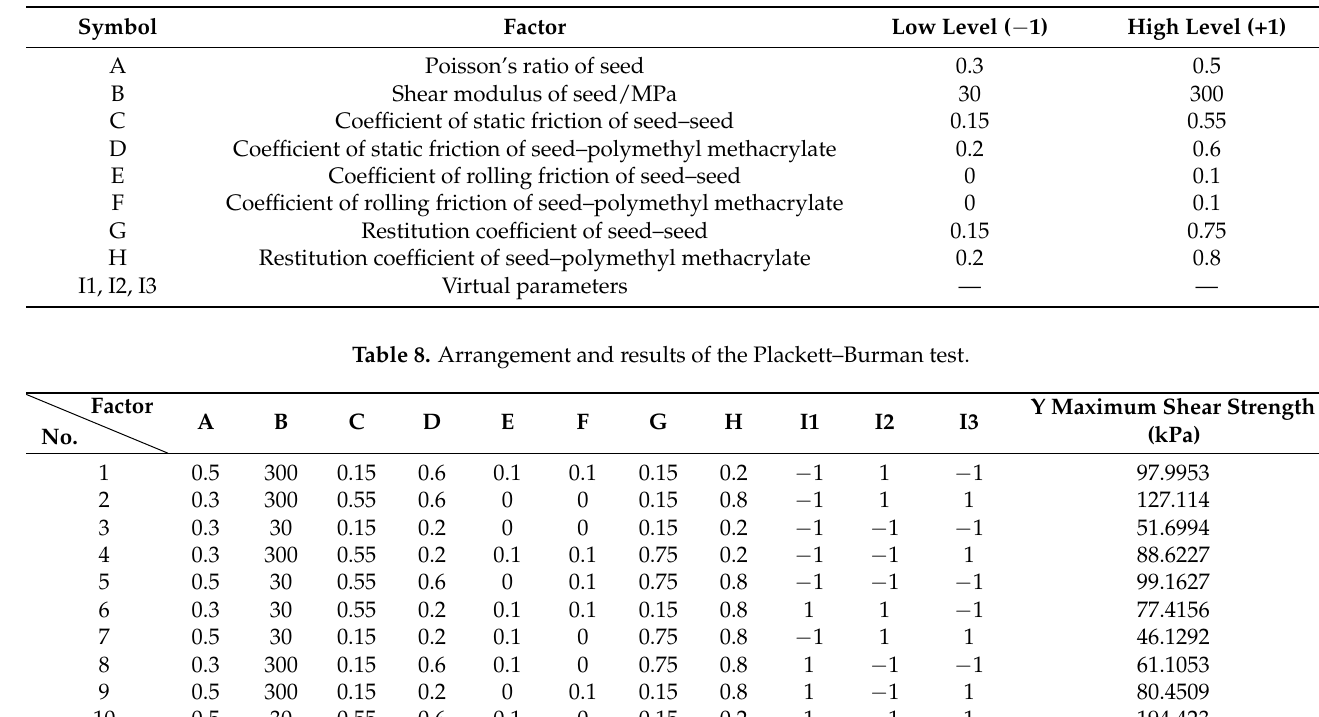
Table 7. Factors and levels of the Plackett–Burman test.